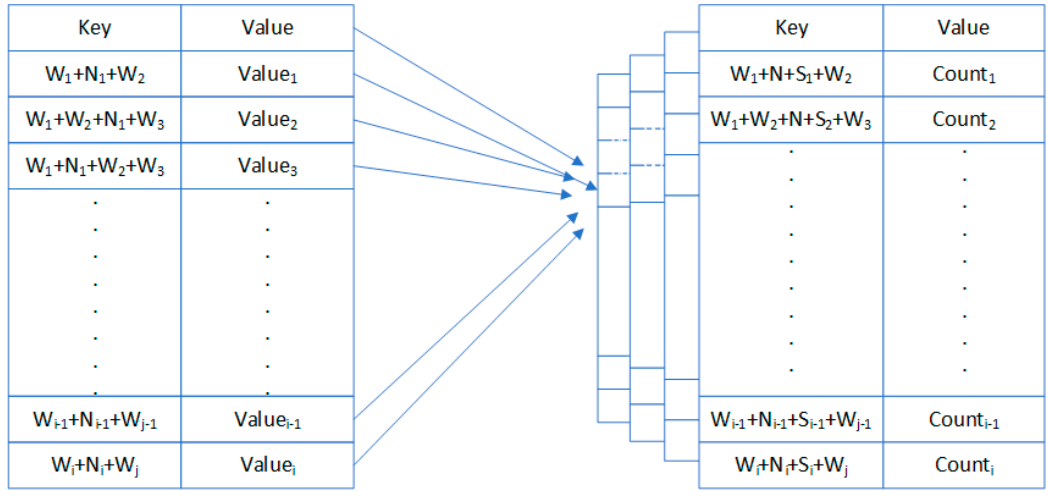
Figure 1. Diagram of a nested hash table.